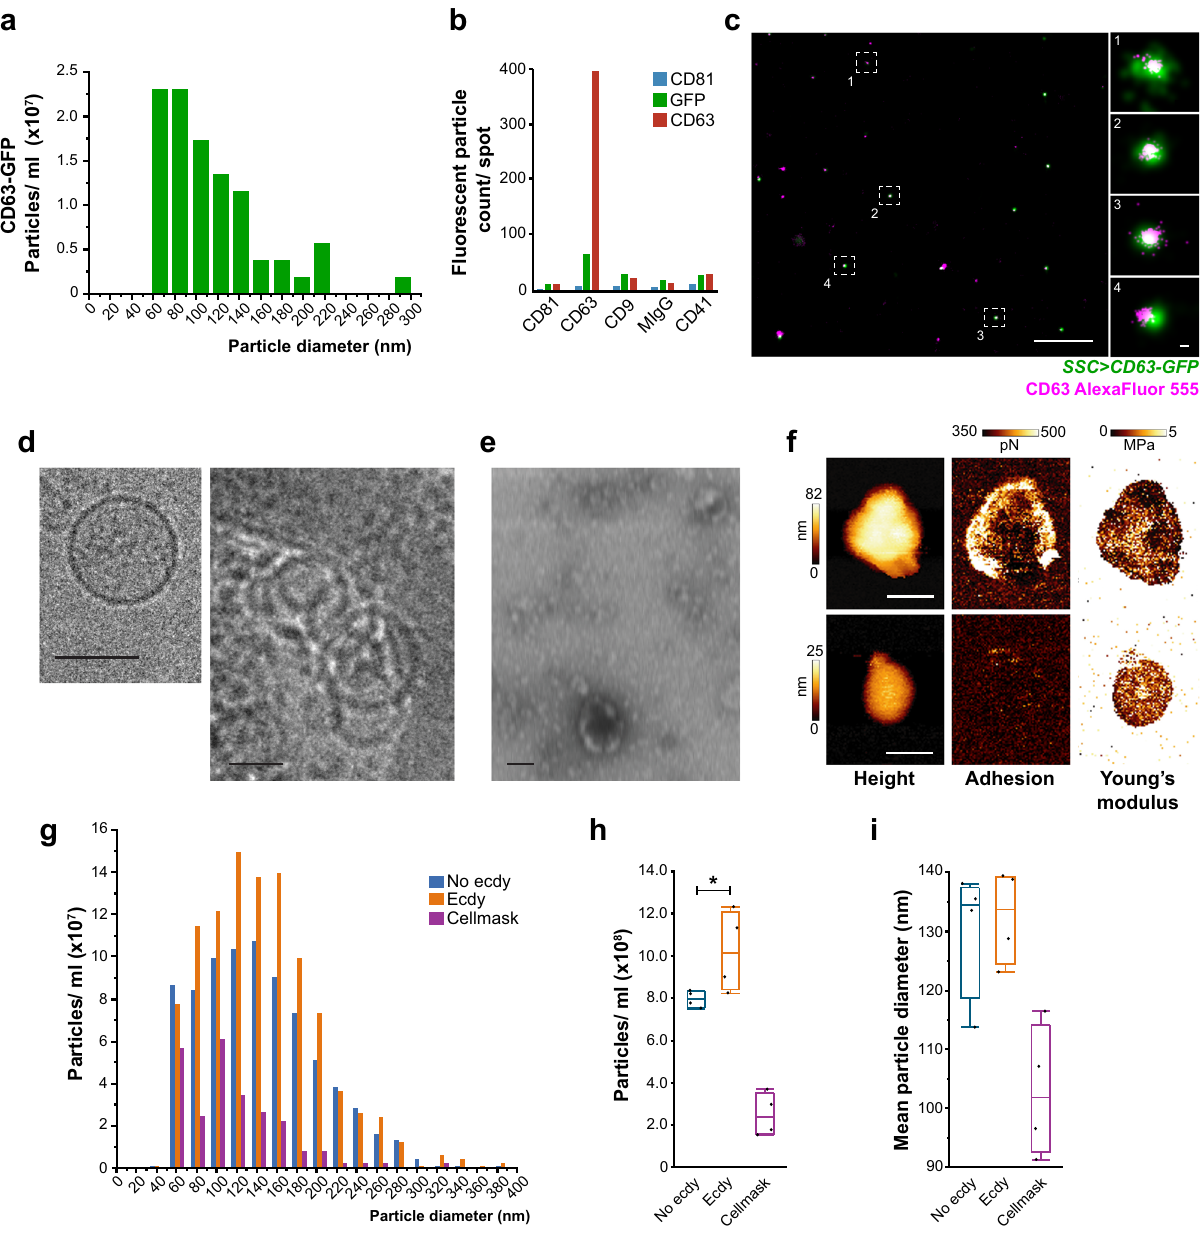
Fig. 5 The spermatheca releases EVs with speci fi c characteristics. a – e The spermathecae (SSC > CD63-GFP) were cultured ex vivo to characterize the particles that were released to the spent media: a size distribution of CD63-GFP-positive particles ( n = 25 spermathecae from 15 fl ies) using single-particle tracking of the Nanoimager. b Characterization of CD63-GFP particles by ExoView (100 spermathecae from 50-60 fl ies) using anti-GFP or anti-CD63. c Representative dSTORM image of EVs found in the spent media of SSC expressing CD63-GFP ( n = 25 spermathecae from 15 fl ies), stained with AlexaFluor555 conjugated anti-CD63 primary antibody. The image shows CD63-GFP-positive EVs and single CD63 AlexaFluor555 molecules the EV ’ s surface. Scale bars = 1 µ m and insets = 20 nm. d – e The morphology of EVs in the spent media was observed by e negative staining in STEM; scale bar = 200 nm; and by d Cryo-TEM; Scale bar = 100 nm (see also Supplementary Fig. 5a-c). f – i The spent media of ex vivo cultured spermathecae were analyzed for the presence of EVs: f Representative AFM scans of SSC-EVs isolated by acoustic sorting ( n = 100 spermathecae from 70 fl ies), showing from left to right: height (nm), adhesion (pN) and Young ’ s modulus images (MPa). Scale bars = 100 nm (see Supplementary Fig. 5d – g). g – i Single-particle tracking in the nanoimager. g CellMask TM -positive particle size distribution and concentration pro fi les of EVs in the spent media of spermathecae incubated in media alone (No ecdy) or with ecdysone (Ecdy) (see also Supplementary Movie 5 for a time lapse of spermathecae end apparatus and endosomal activity post-ecdysone stimulation and methods, ex vivo spermatheca culture section); media with only CellMask TM stain served as a control for the formation of dye aggregates. h Particle concentration and i mean particle diameter (nm) from g ; Box plots are the measurements of particles from four frames of spent media from 25 spermathecae; boxes represent maximum, median and minimum values with outliers; one-way ANOVA, with nonparametric Wilcoxon multiple comparison post-hoc test; * p <